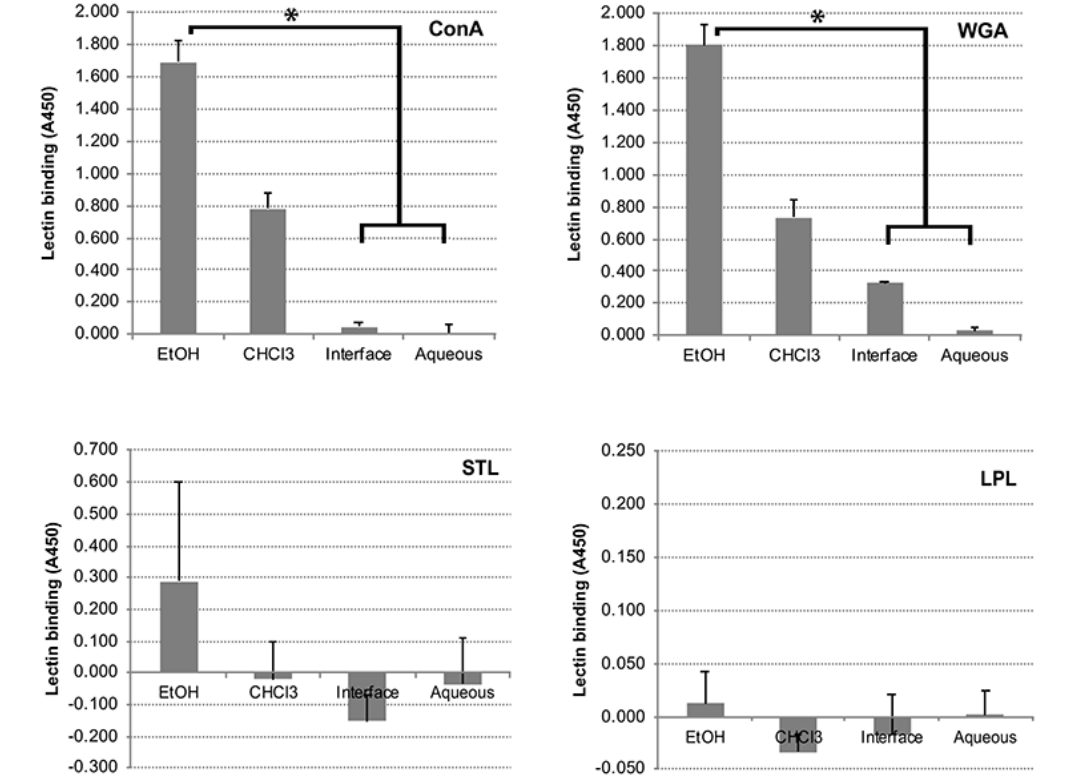
Figure 5. Lectin binding to the Map EtOH extract. Lectin binding was detected using peroxidase-conjugated secondary antibody and peroxidase substrate (ABTS) followed by measuring absorbance at 415 nm. Histogram bars represent mean lectin binding ± standard deviation of quadruplicate determinations. Binding to both concanavalin A (ConA) (top left) and wheat germ agglutinin (WGA) (top right) was observed predominantly in the chloroform phase with little to no binding in the aqueous phase. Conversely, no Solanum tuberosum lectin (STL) (bottom left) or Limulus Polyphemus lectin (LPL) (bottom right) binding was observed in any fraction of the extract, while a low but detectable binding level was observed in the complete extract with STL. An asterisk denotes p values less than 0.01.